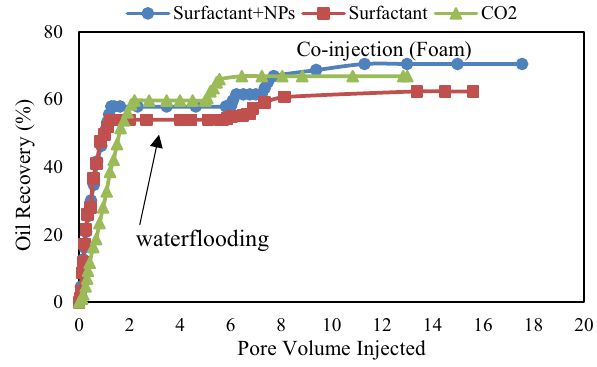
Fig. 6 Oil recovery following waterflooding, CO non-fractured rocks